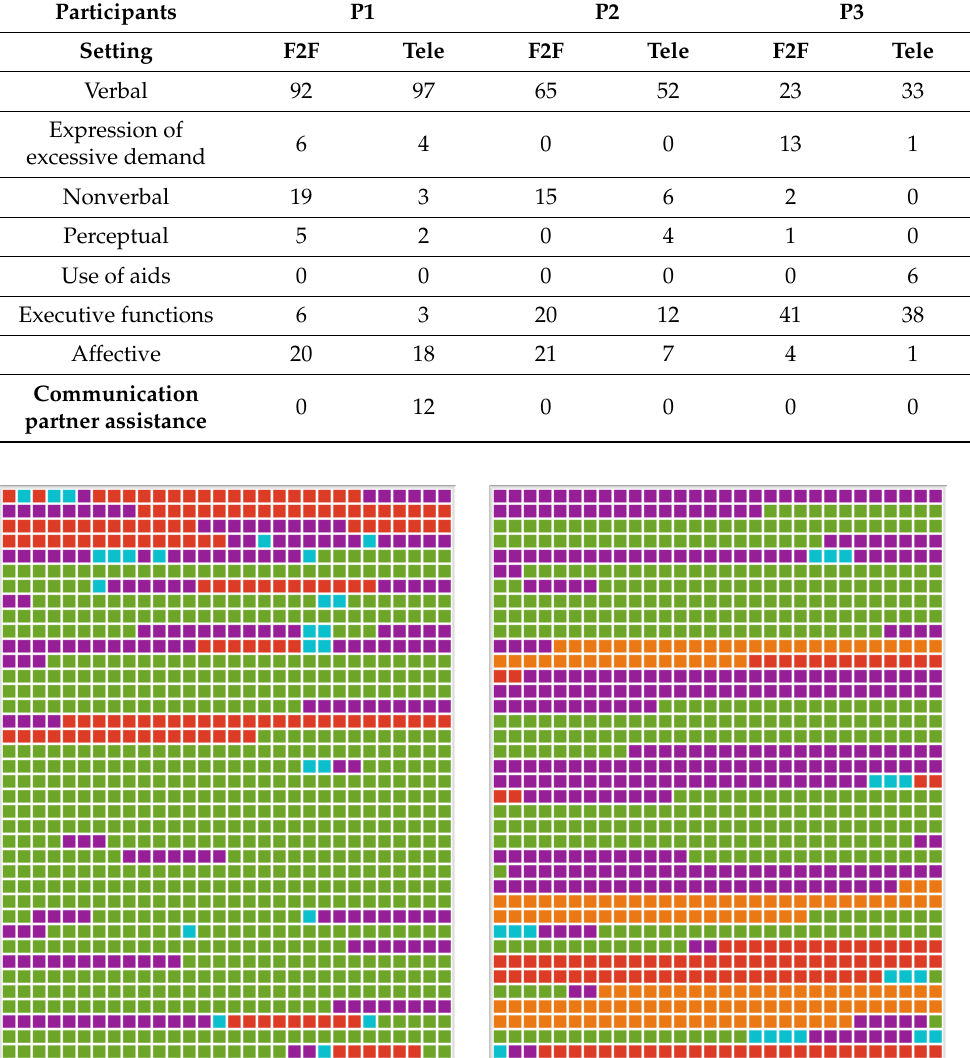
Table 3. Document variables. F2F = face-to-face diagnostics. Tele = telediagnostics.